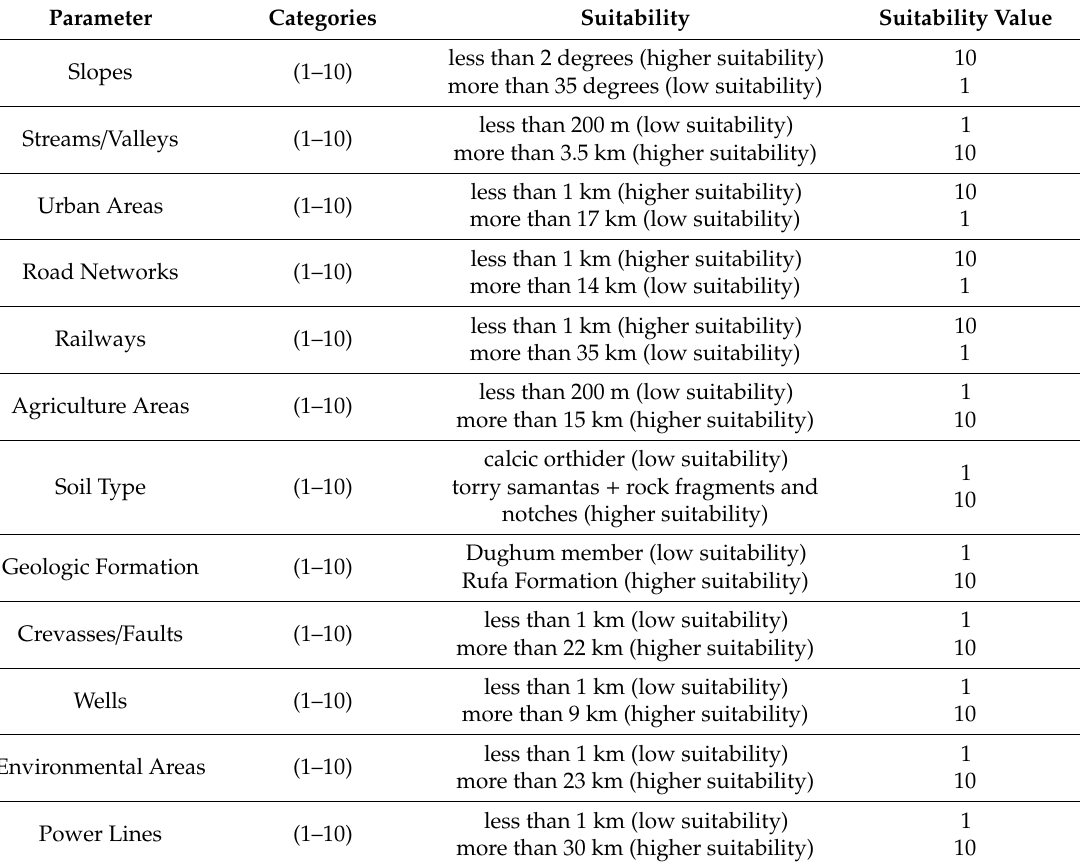
Table 2. Category classification and suitability for the di ff erent criteria a ff ecting the rural–urban continuum between Ar Riyadh and Al